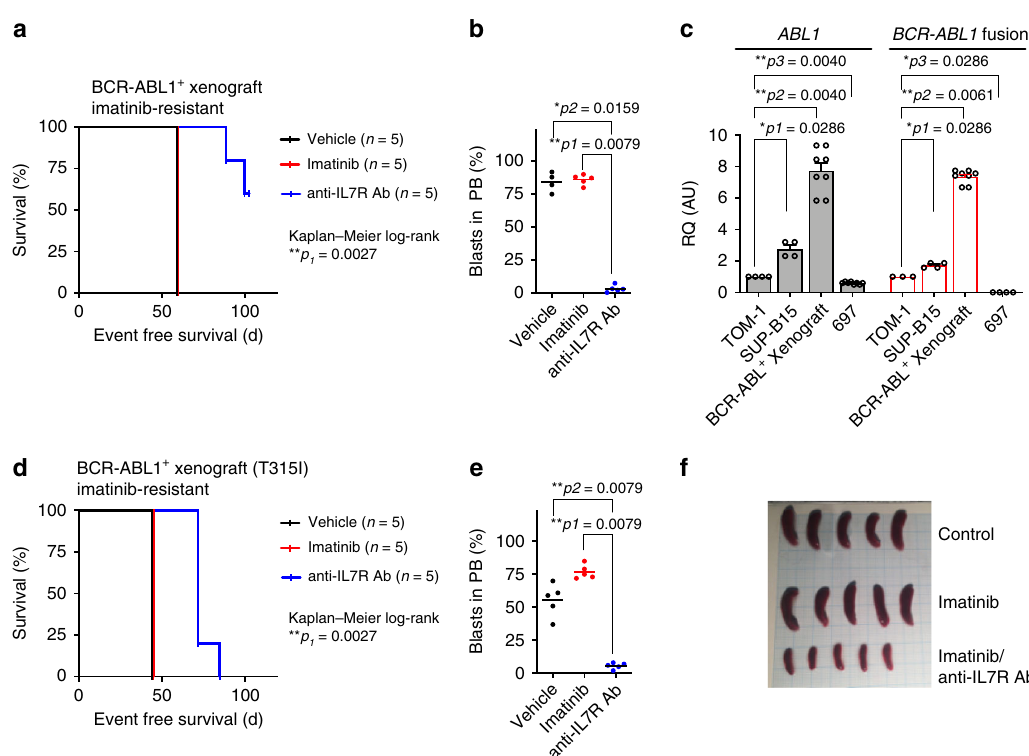
Fig. 7 Anti-IL7R antibody suppresses BCR-ABL1 + ALL development in vivo. a , b 1 × 10 6 BCR-ABL1 + ALL patient cells were xenografted by tail vein injection into NSG mice. Xenografted mice were treated with vehicle, imatinib, or with anti-IL7R antibody ( n = 5 per group) as described in “ Methods ” . a Survival prolongation in xenografted mice subjected to the indicated treatment. Mantel – Cox-log-rank test, **p = 0.0027. b Leukemic engraftment was measured by fl ow cytometry in peripheral blood (PB) at day 58 and all control and imatinib-treated mice were sacri fi ced due to appearance of leukemic symptoms. Unpaired t -test, two-sided p value. c Expression levels of ABL1 or BCR-ABL1 fusion in BCR-ABL1 + human cell lines (TOM-1 and SUP-15), and in imatinib-resistant xenograft-derived human BCR-ABL1 + cells. 697 cell line, was used as a negative control for the fusion. Expression levels are normalized to TOM-1. Error bars represent mean ± SEM. Unpaired t -test, two-sided. RQ: relative quanti fi cation; AU arbitrary unit. d – f 1 × 10 6 BCR-ABL1 + ALL patient cells holding T315I mutation (imatinib-resistant) were injected intravenously into NSG mice and treated with anti-IL7R antibody or with imatinib. d Survival prolongation in mice xenografted with Ph + BCP-ALL patient material holding the T315I mutation and treated with either imatinib or with anti-IL7R antibody. Mantel – Cox-log-rank test, **p = 0.0027. e Leukemic engraftment was measured by fl ow cytometry in PB at day 42. Unpaired t -test, two-sided. f Spleen size at day 45 of xenograft mice treated with either imatinib or a combination of imatinib and anti-IL7R